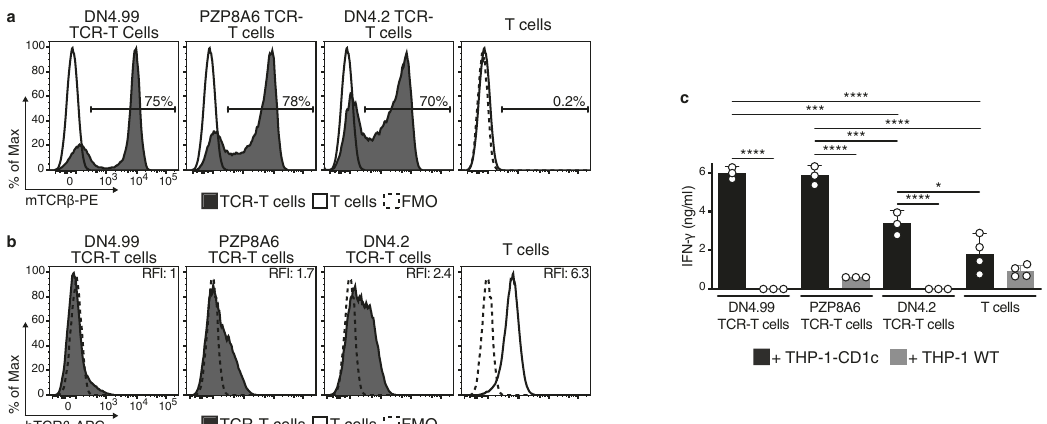
Fig. 3 Primary T cell transduction con fi rm the DN4.99 TCR as lead CD1c-restricted mLPA-speci fi c TCR to target acute leukemia. DN4.99, PZP8A6, and DN4.2 TCRs were transduced into primary T cells. a Chimeric TCR expression on transduced (black histograms) and non-transduced primary polyclonal T cells (white histograms) determined by labeling with anti-mouse TCR β (mTCR β ) monoclonal antibody (mAb). b Endogenous human TCR expression in chimeric TCR-transduced (black histograms) and non-transduced T cells (white histograms) determined at the same time point as in ( a ) by labeling with anti-human TCR β (hTCR β ) mAb. Dotted histograms represent Fluorescence-Minus-One (FMO) labeling control. Relative Fluorescence Intensity (RFI) was calculated as the ratio between the intensity of labeling of the sample and control. c Recognition of THP-1-CD1c (black histograms) but not of THP-1-Wild- Type (WT) cells (gray histograms) by human primary T cells 18 days after their transduction with the indicated chimeric TCRs, determined by measuring the secreted IFN- γ in the supernatant of 2.5:1 Effector:Target ratio co-cultures. Data are represented as mean ± SD. Results are representative of 2 (for PZP8A6 TCR-T cell and DN4.2 TCR-T cells) or 4 independent experiments (for DN4.99 TCR-T cells) with n = 3 independent replicates per experiment. * P = 0.0245; *** P = 0.0003 DN4.99 TCR-T cells; *** P = 0.0005 PZP8A6 TCR-T cells; **** P < 0.0001 determined by Ordinary one-way ANOVA followed